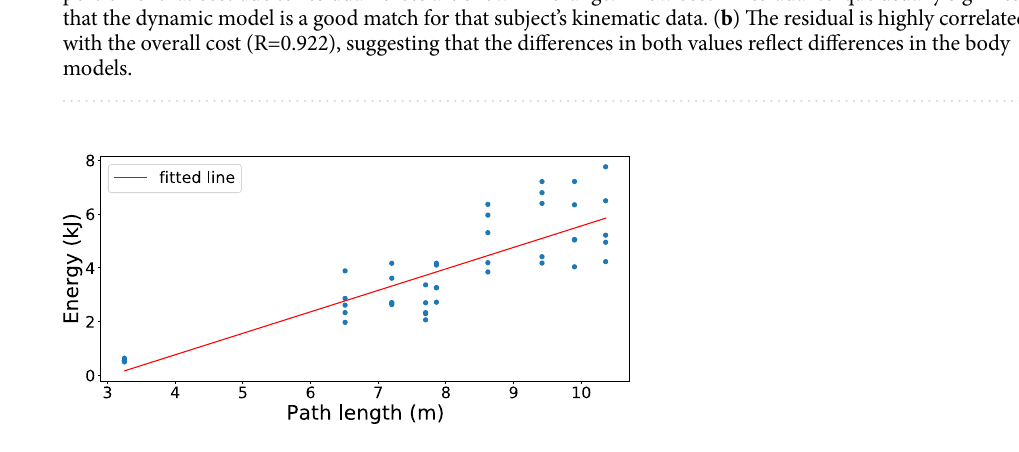
Figure 4. The energy cost of tracing nine paths. These results portray the possibility that the costs vary across the best-fit five subjects. The statistics show that each path traced has a unique cost based on its length that distinguishes it from the rest. The correlation between the length and cost of tracing shows a R value of